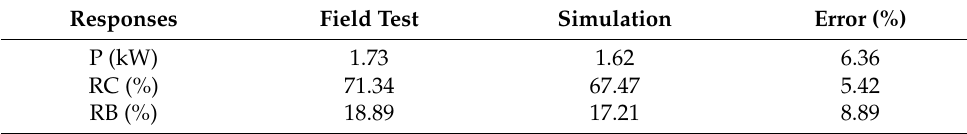
Table 10. Comparison of simulation and test results under optimal